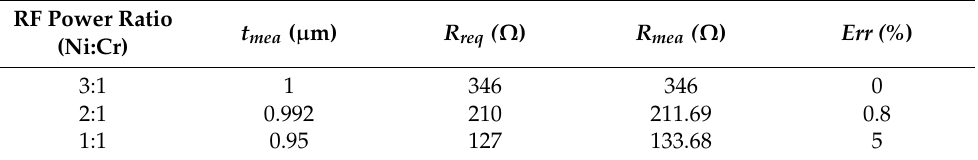
Table 3. Characteristics of measured Ni/Cr alloy thin-film